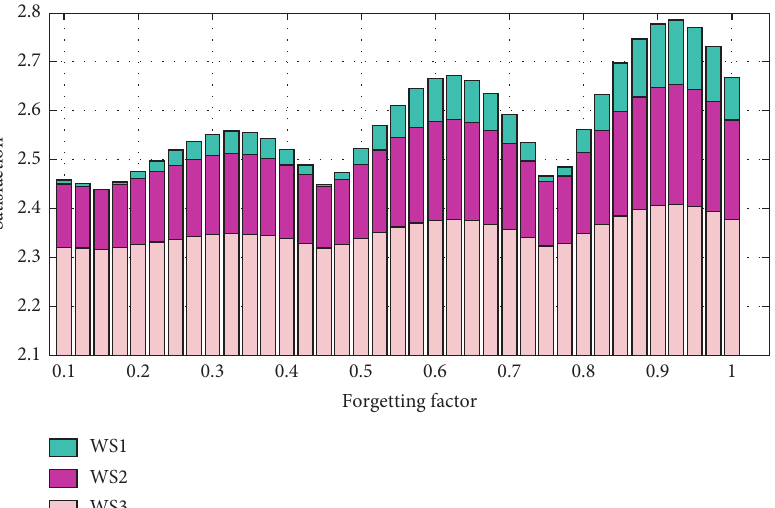
Figure 7: Calculating satisfaction based on forgetting factor.